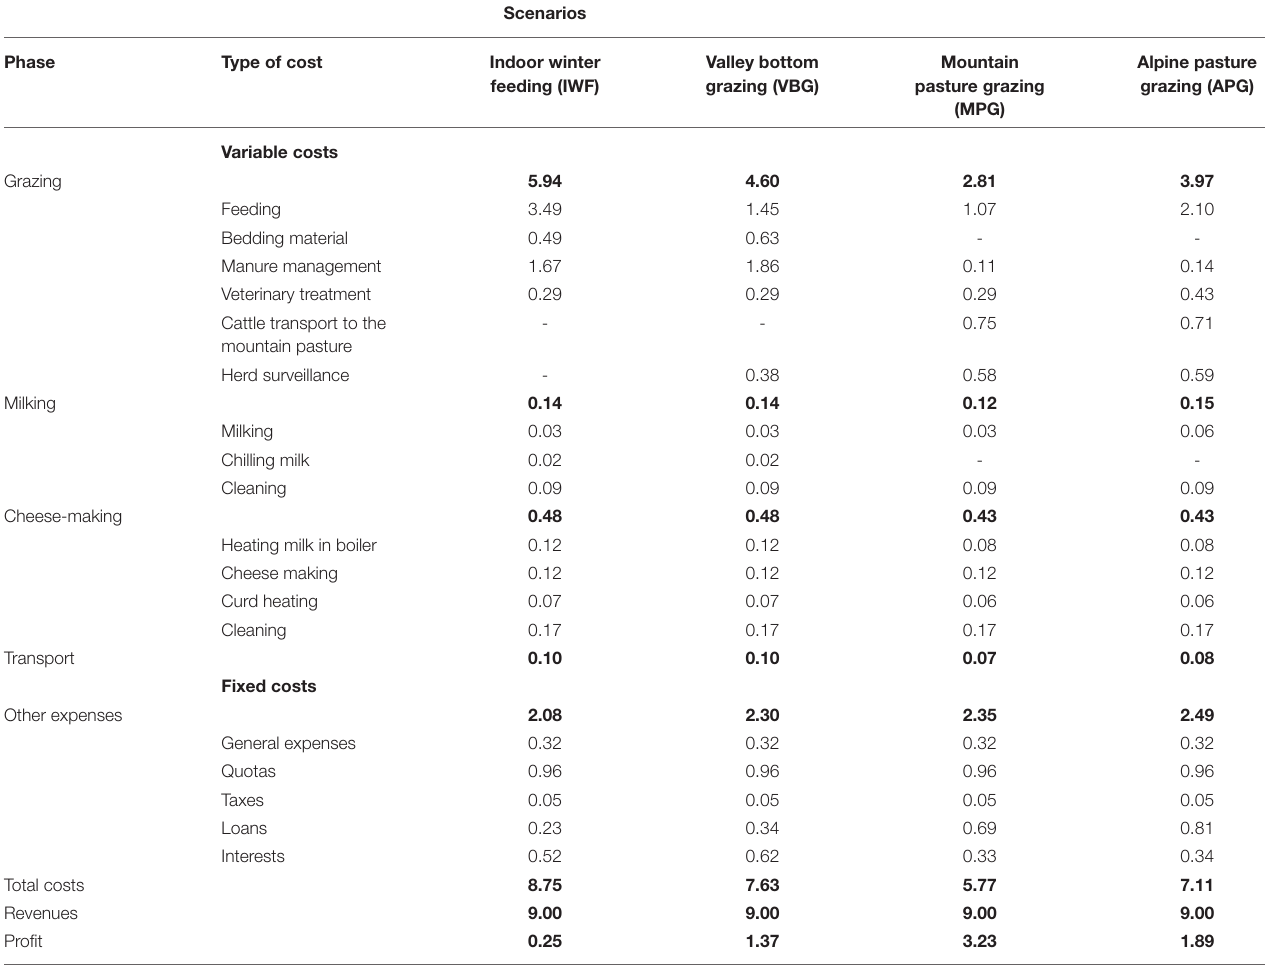
TABLE 3 | Economic results [ e kg − 1